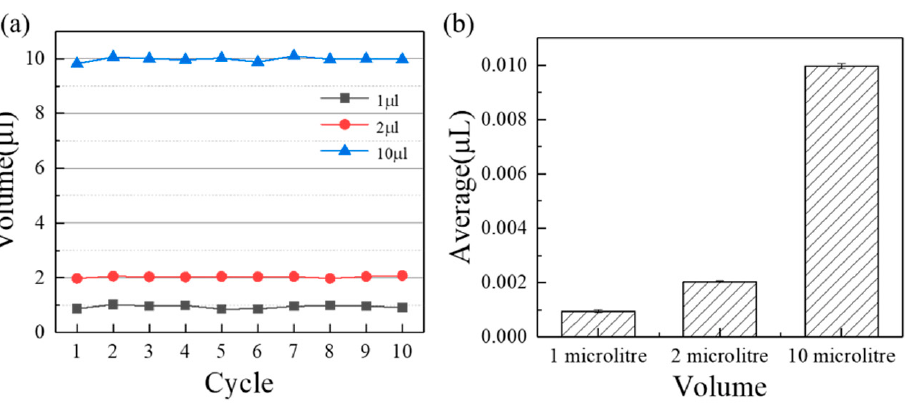
Figure 3. The measurement results of the three-dimensional precision automatic pipette in 10 μL , 2 μL , 1 μL : ( a ) Overall results, ( b ) Average results. 2 µ L, 1 µ L: ( a ) Overall results, ( b ) Average